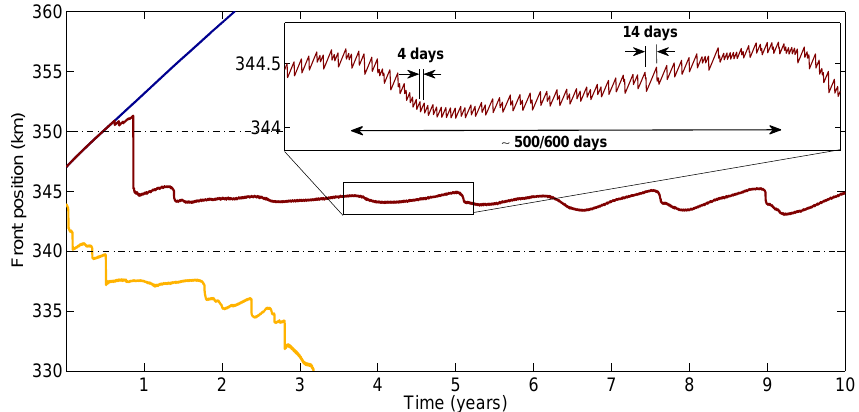
Figure 6. Positions of the calving front over the 10-year period. Each colour corresponds to a set of parameters σ th , B , and D c . Blue represents an advance with almost no calving ( σ th = 0.15MPa, B = 0.84MPa − 1 , and D c = 0.6) ; yellow represents a major retreat ( σ th = 0.10MPa, B = 1.75MPa − 1 , and D c = 0.4) ; red represents a behaviour that is consistent with observations ( σ th = 0.11MPa, B = 1.30MPa − 1 , and D c = 0.50). The inset shows a close-up of the consistent case.